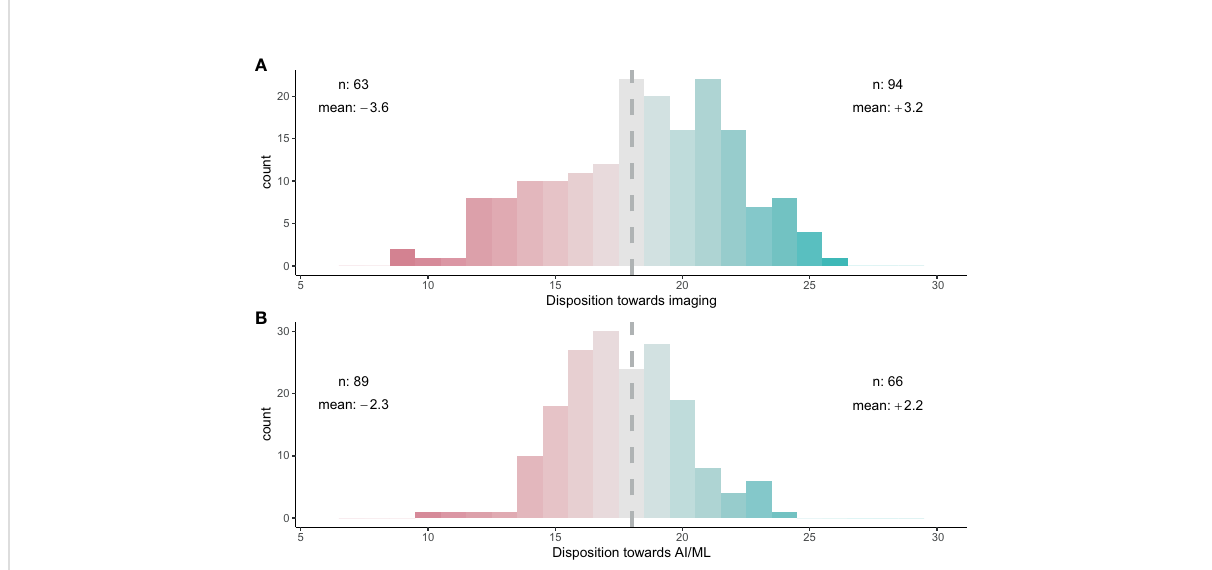
FIGURE 4 Overall trust in (A) imaging for zooplankton taxonomy and (B) AI/ML for zooplankton taxonomy. A score of 18 indicates a neutral stance towards imaging or AI/ML. A trust score of >18 (green) indicates a favourable disposition towards the technology, while a score of < 18 (red) indicates a negative disposition. ‘ n ’ shows the number of participants on either side of 18. ‘ mean ’ shows the average score above or below 18, with a higher absolute number indicating a stronger community bias.